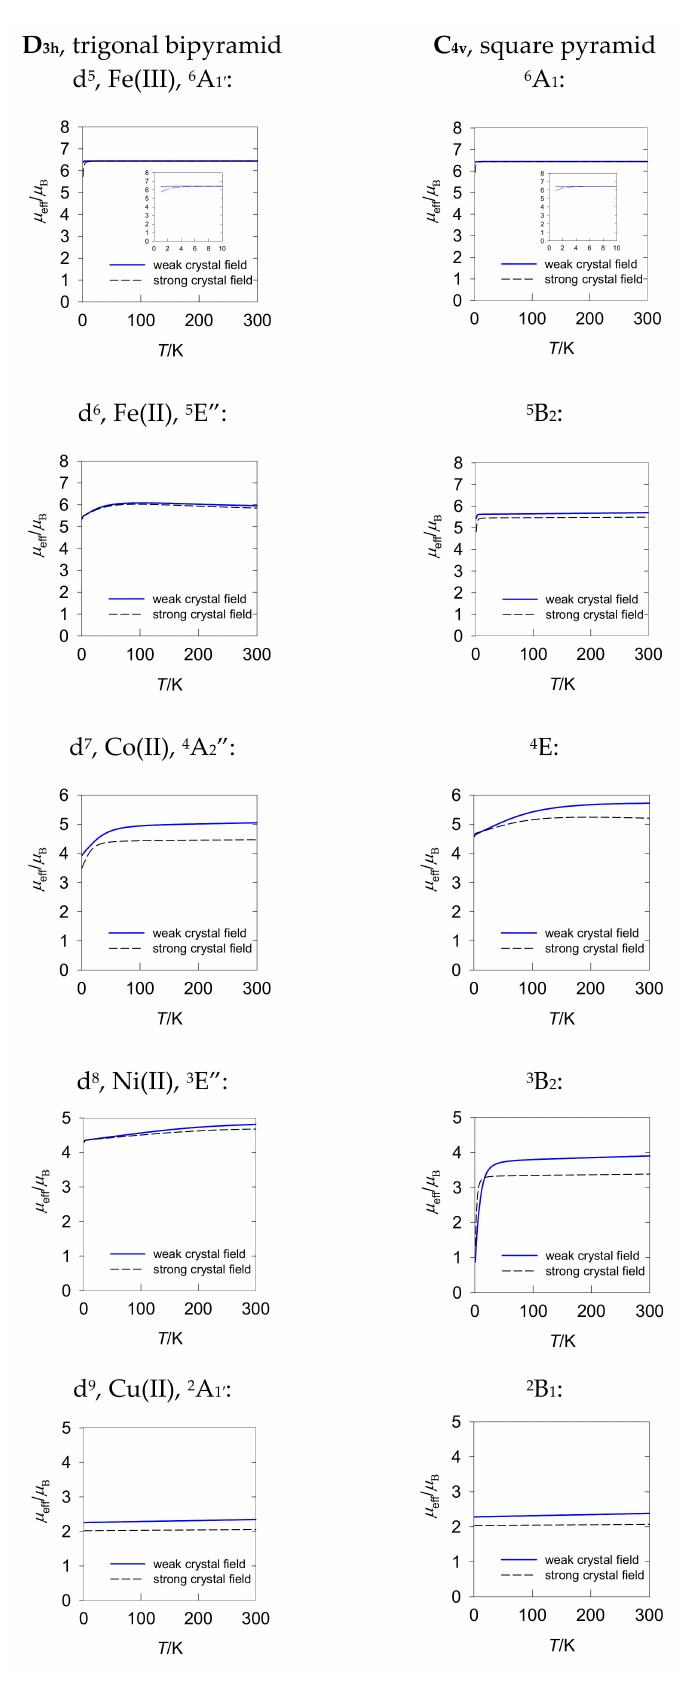
Figure 4. DC susceptibility functions at B = 0.1 T (Equation (12)) converted to the effective magnetic moments as calculated by GCFT for a weak (strong) crystal field with F 4 = 5000 (15,000) cm − 1